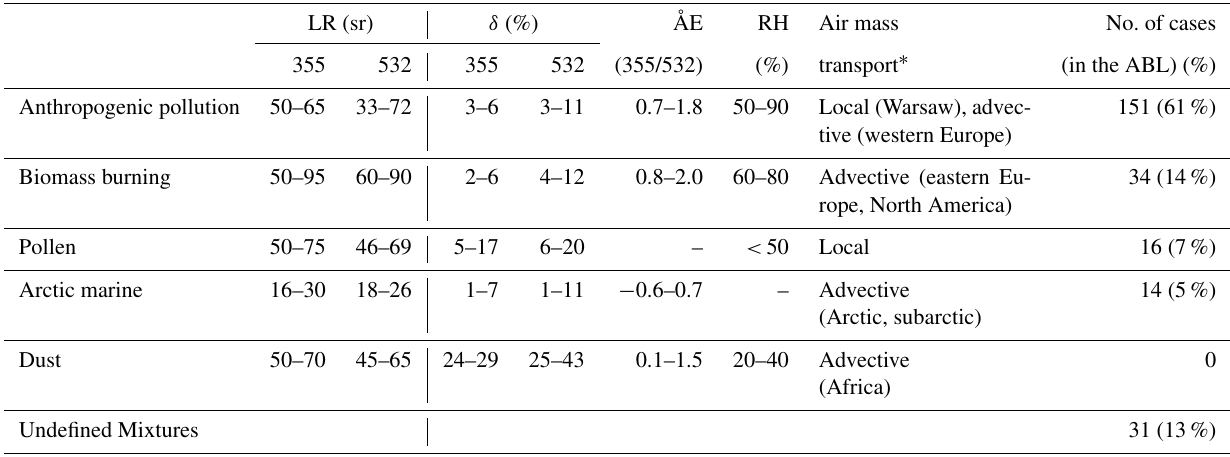
Table 1. Literature review based on the values of the lidar-derived particle optical properties used for the interpretation of aerosol measured over the RS-Lab in Warsaw. The listed properties are assessed in each aerosol layer based on a manual approach in combination with case-to-case air mass transport